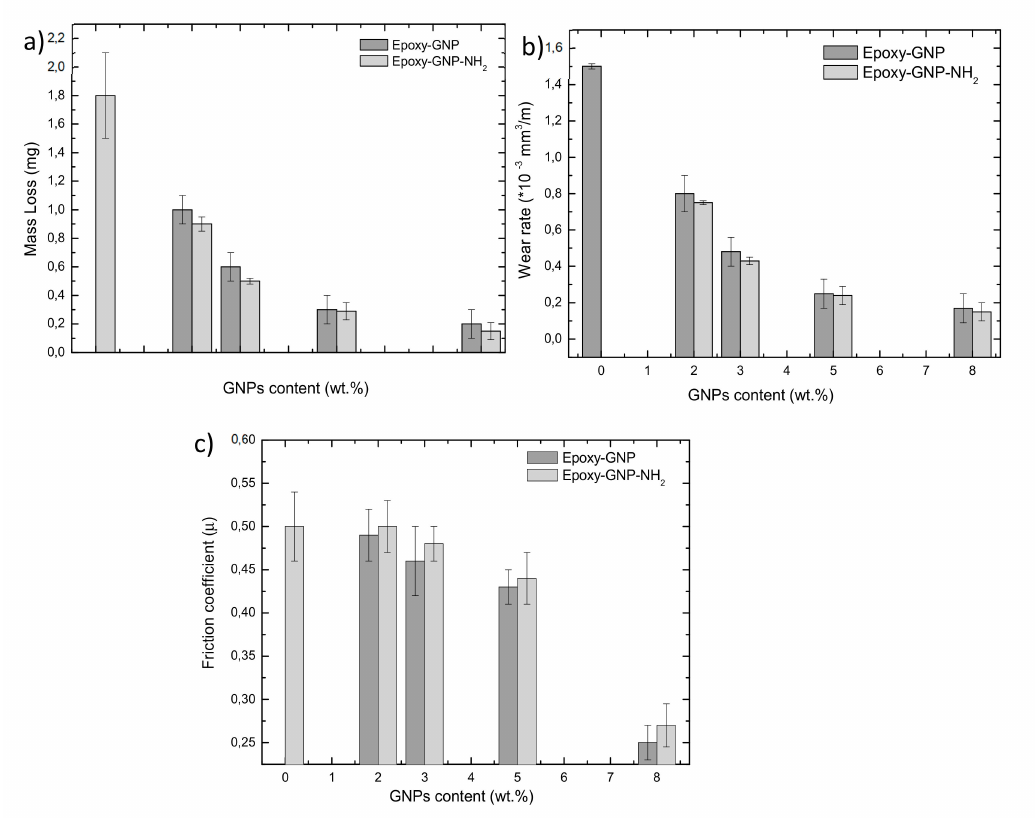
Figure 4. Mass loss ( a ), wear rate ( b ) and friction coe ffi cient ( c ) of epoxy / GNPs nanocomposites with di ff erent contents and types of